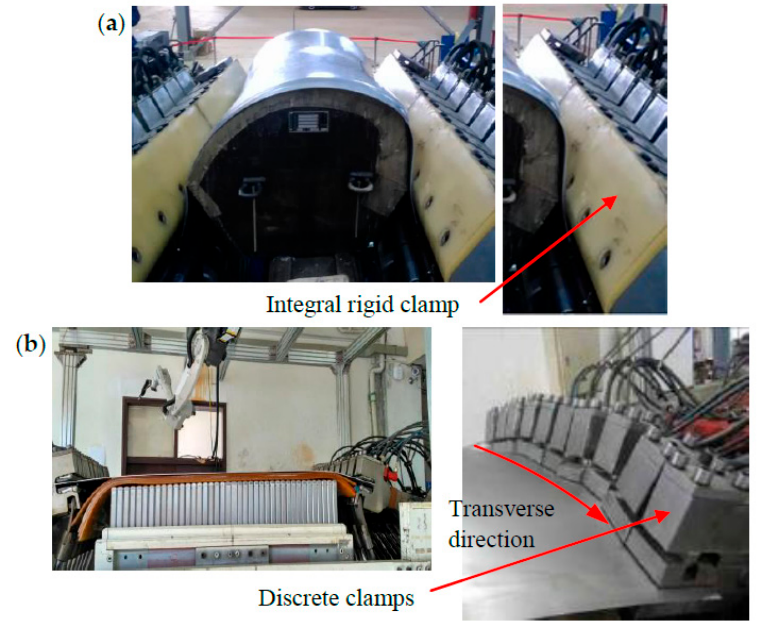
Figure 1. Clamp in stretch forming process. ( a ) Integral rigid clamp; ( b ) discrete clamps.